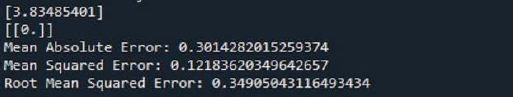
Fig 4. Linear regression fit in a scatter plot.